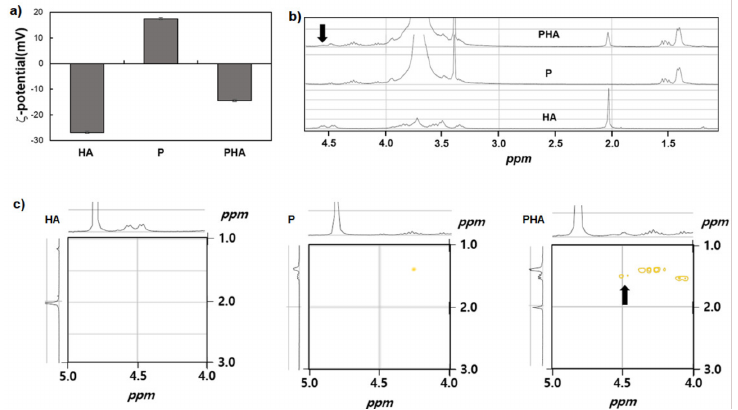
Figure 2. ( a ) Zeta-potential of HA, P, and PHA aqueous solutions. (1.0 wt.%) ( b ) 1 H-NMR and ( c ) 2D-NMR spectra of HA, P, and PHA (25 ◦ C in D 2